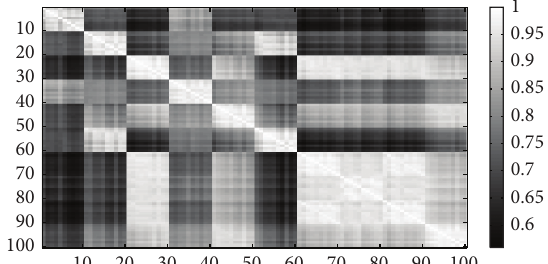
Figure 10: Redundancy values between the features calculated by mutual